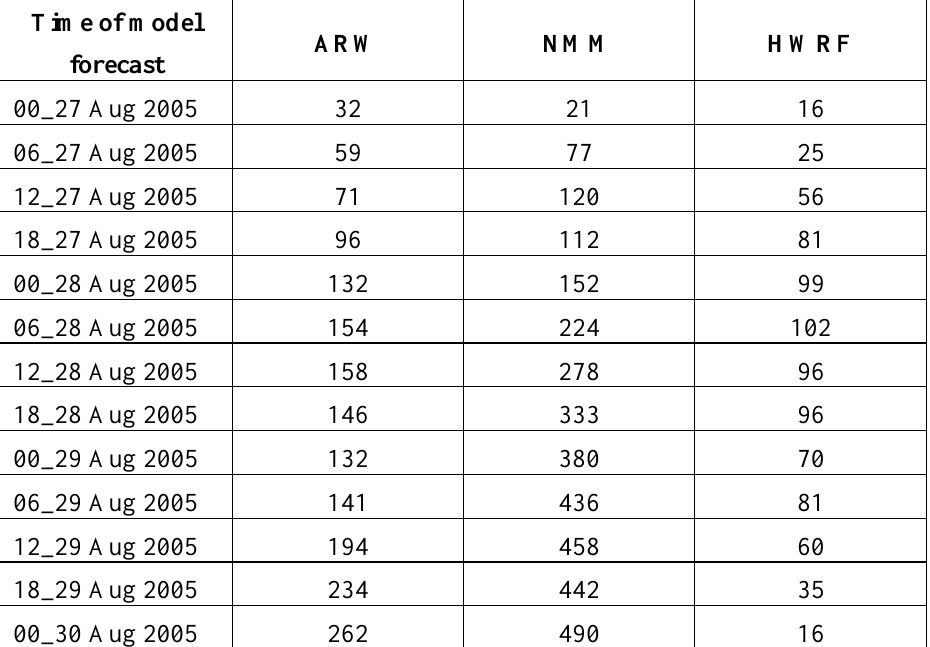
Table 2. Vector track position errors